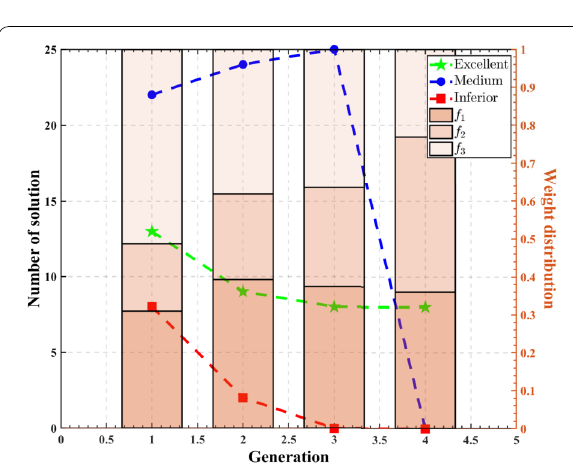
Figure 7 Iterative variation of decision set size and objective entropy